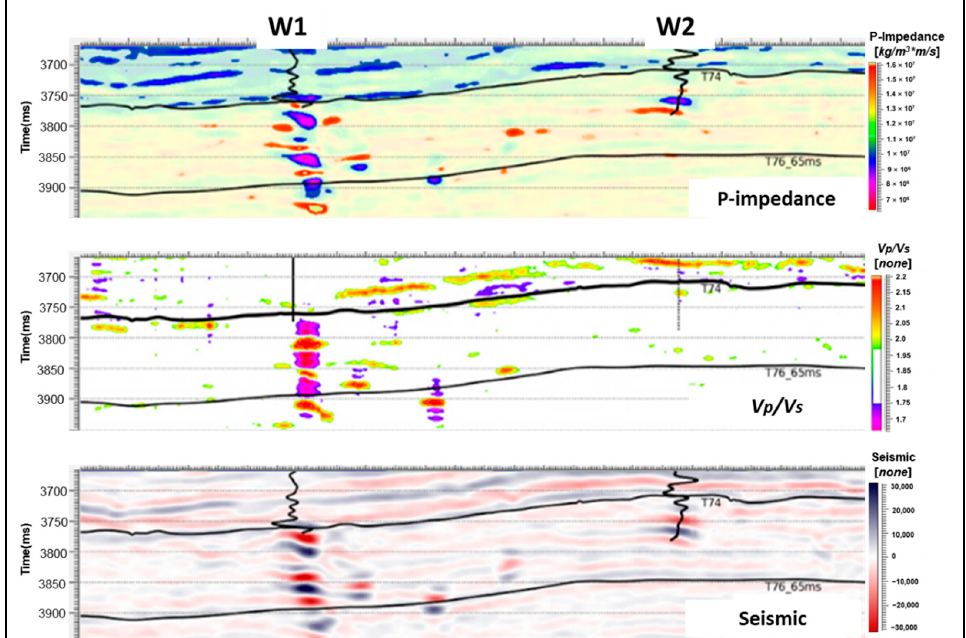
Figure 10. Predicting cave-filling fluids based on pre-stack inversion.